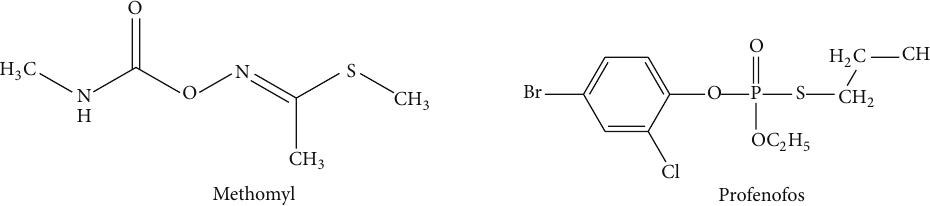
Figure 1: Molecular structures of methomyl and